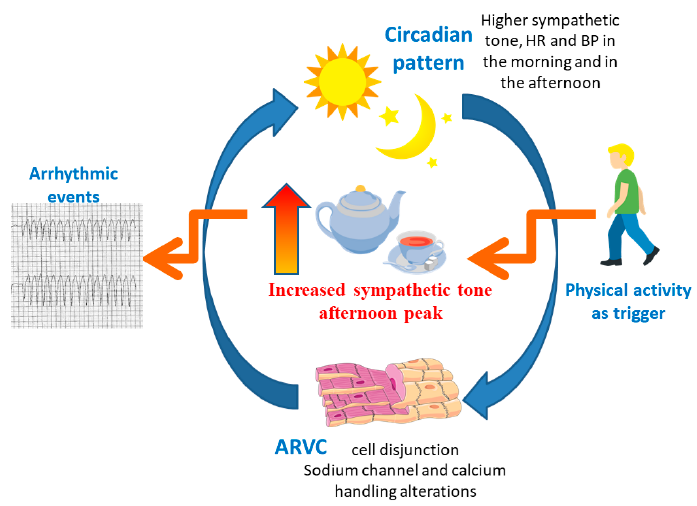
Figure 5. Illustration of the causes of the higher number of arrhythmic events in the afternoon. According to the circadian pattern, sympathetic tone (along with the heart rate and blood pressure) is higher in the early morning and in the late afternoon and lower during the evening and the night [32]. Desmosomal remodelling causes sodium channel and calcium handling alterations, with electromechanical alterations [26,31] that are part of the arrhythmic substrate. Ion channels and calcium handling are also circadian-regulated [19]. Their alteration causes a circadian rhythm malfunction with a further increase in sympathetic tone [28]. The threshold for arrhythmic events is, therefore, lower. Moreover, in the afternoon, the level of physical activity is higher than in the morning [33–36]. Therefore, increased physical activity may act as a trigger for ventricular arrhythmia in the afternoon. Free clip art from https://creazilla.com (accessed on 9 February 2022) and https://smart.servier.com (accessed on 9 February 2022).